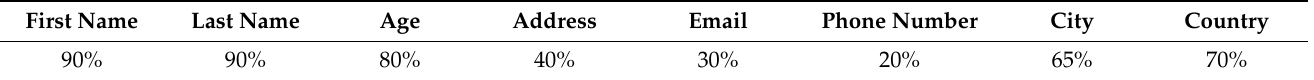
Table 3. Customers’ dataset fields and their completeness